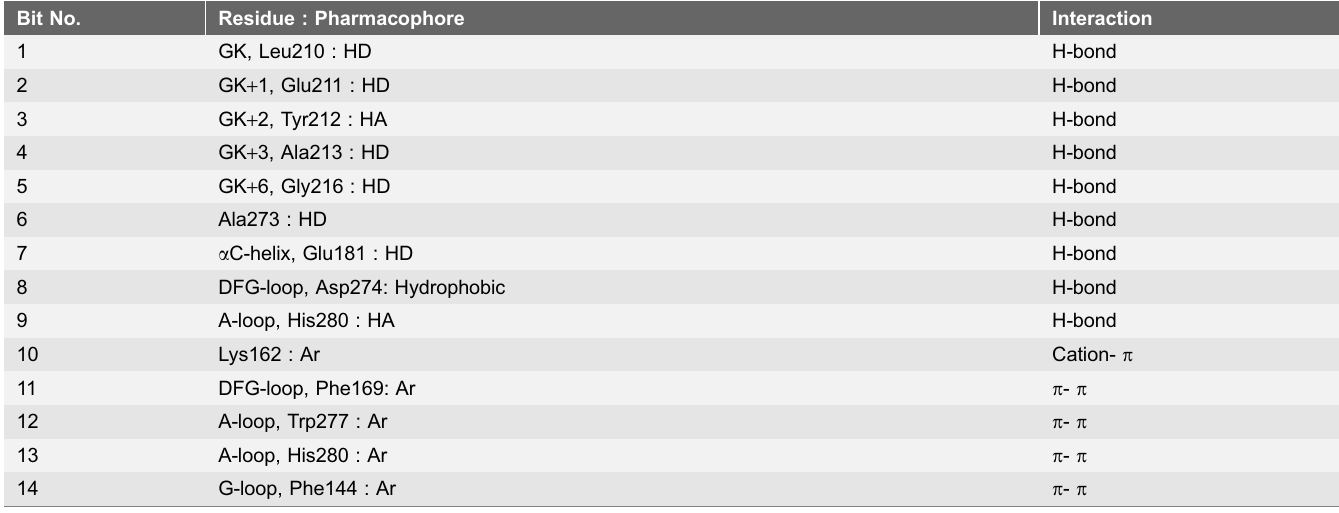
Table 3. Features of the 14 bit-vector used to deduce the interaction fingerprints. Bit